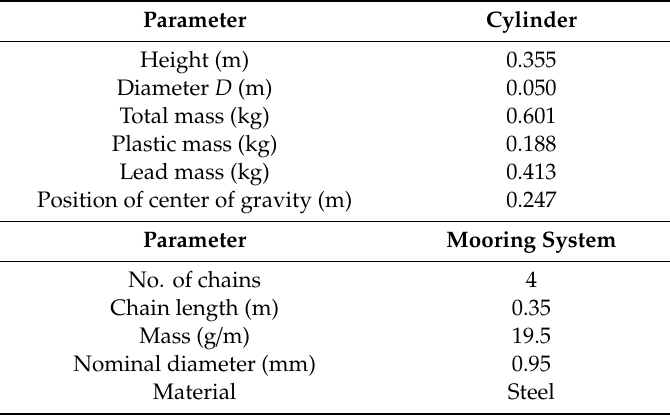
Figure 2. Lateral ( a ) and top ( b ) views of the tested cylinder (measures in mm). Table 1. Characteristics of the cylinder buoy and of the mooring system.